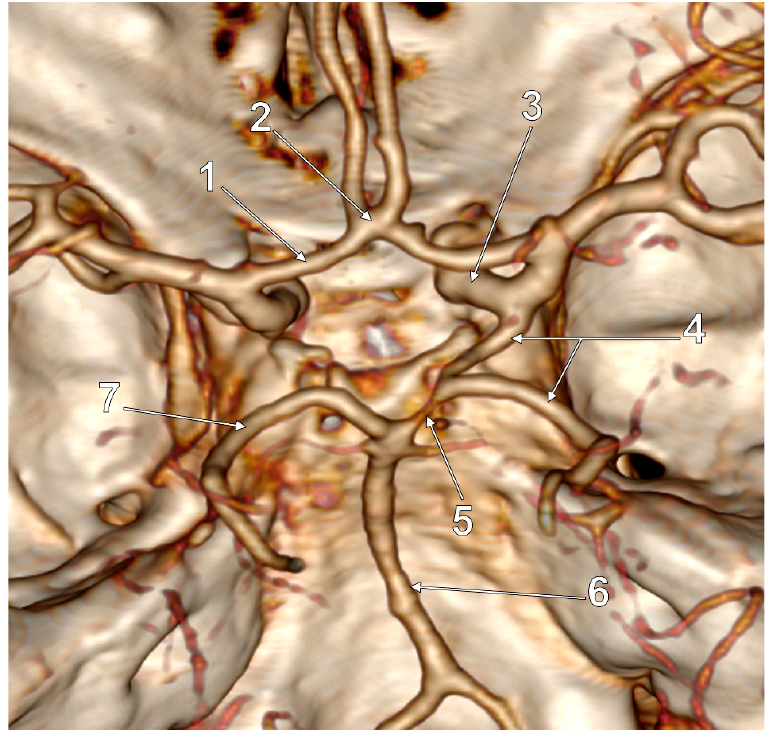
Figure 2. Postero-superior view of the cW. Unilateral partial FPCA (p-FPCA). Two variant sides of the cW: hypoplastic right P1 and aplastic left PComA. 1. A1 segment of the left ACA; 2. AComA; 3. Right ICA; 4. Right p-FPCA; 5. Right P1 hypoplasia; 6. BA; 7. Left PCA.